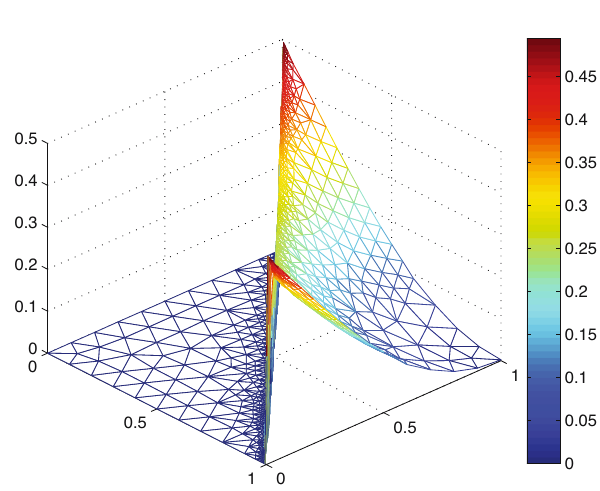
Figure 2: The numerical solution u h at = t 0.5